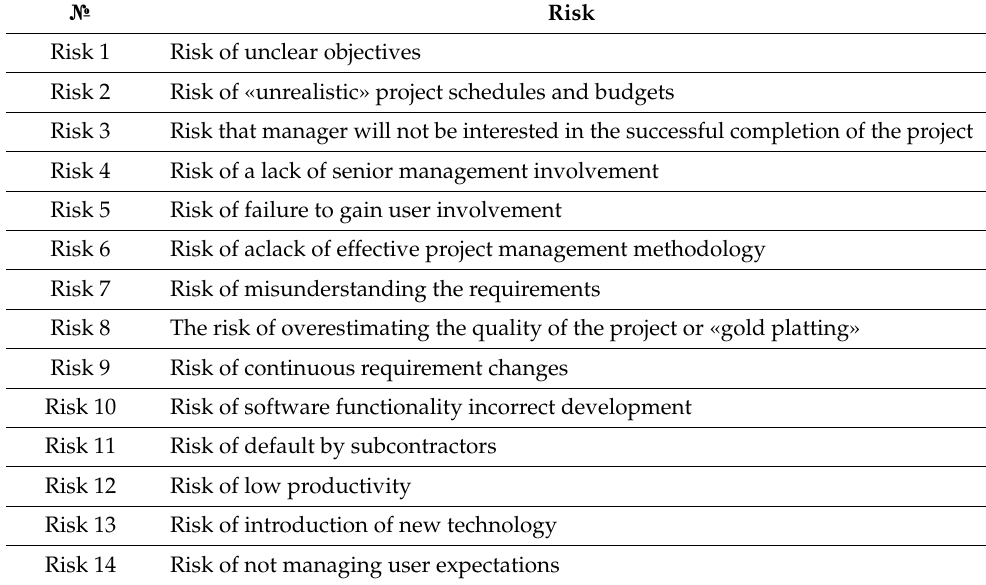
Table 8. List of current IT projects’ risks according to Addison T. and Vallabh S. studies results. № Risk Risk 1 Risk of «unrealistic» project schedules and budgets Risk that manager will not be interested in the successful completion of the